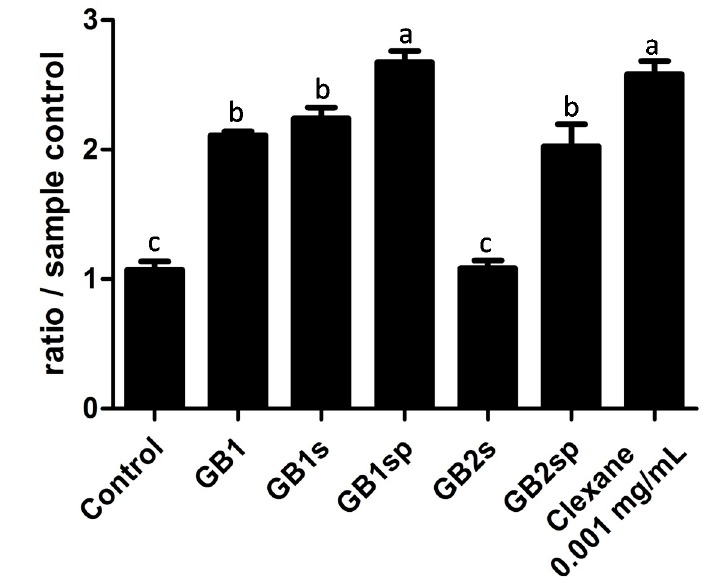
Figure 2. Anticoagulant activity in the activated partial thromboplastin time (aPTT) test of extracts from Gracilaria birdiae. Each value is the mean ± standard deviation of three determinations: a, b, c, different letters refer to a significant difference ( p < 0.05) between each extraction. Clexane ® was used as a positive